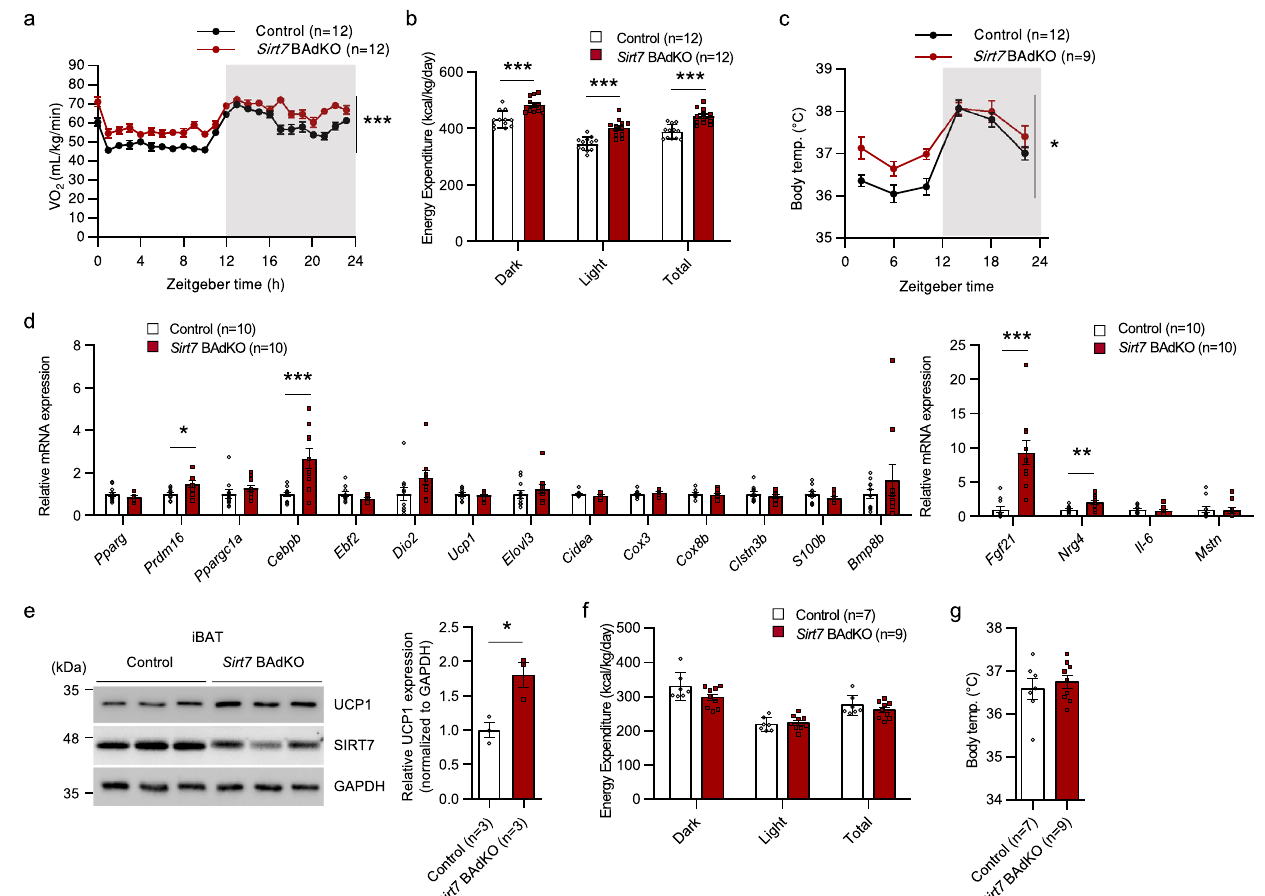
Fig. 5 | Brown adipocytic SIRT7 suppresses energy expenditure and thermo- genesis in vivo. a , b Data of indirect calorimetry experiments and body tempera- ture from 12-week-old male Ucp1 - Cre control and Sirt7 BAdKO mice. VO 2 rates ( a ) and energy expenditure ( b ). p =9.1E – 36 in ( a ); p =1.8E – 04 (Dark), p =3.8E – 05 (Light), p =3.6E – 05(Total)in( b ). c Oscillationofbodytemperaturein20-week-old Ucp1 - Cre control and Sirt7 BAdKO mice. p =0.0399. d Real-time qPCR analysis of BAT-related genes in iBAT of 12-week-old male Ucp1 - Cre control and Sirt7 BAdKO mice. p =0.0245 ( Prdm16 ), p =0.0046 ( Cebpb ), p =0.0009 ( Fgf21 ), p =0.0056 ( Nrg4 ). e WesternblotanalysisofUCP1iniBATof12-week-oldmale Ucp1 - Cre control